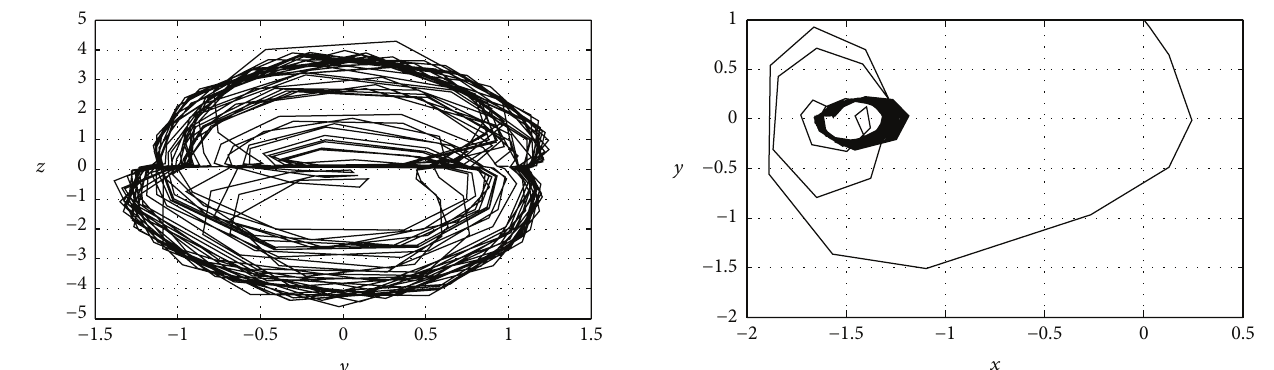
Figure4:3DDuffingchaoticsystemphasediagraminthe 𝑦𝑜𝑧 plane projection.